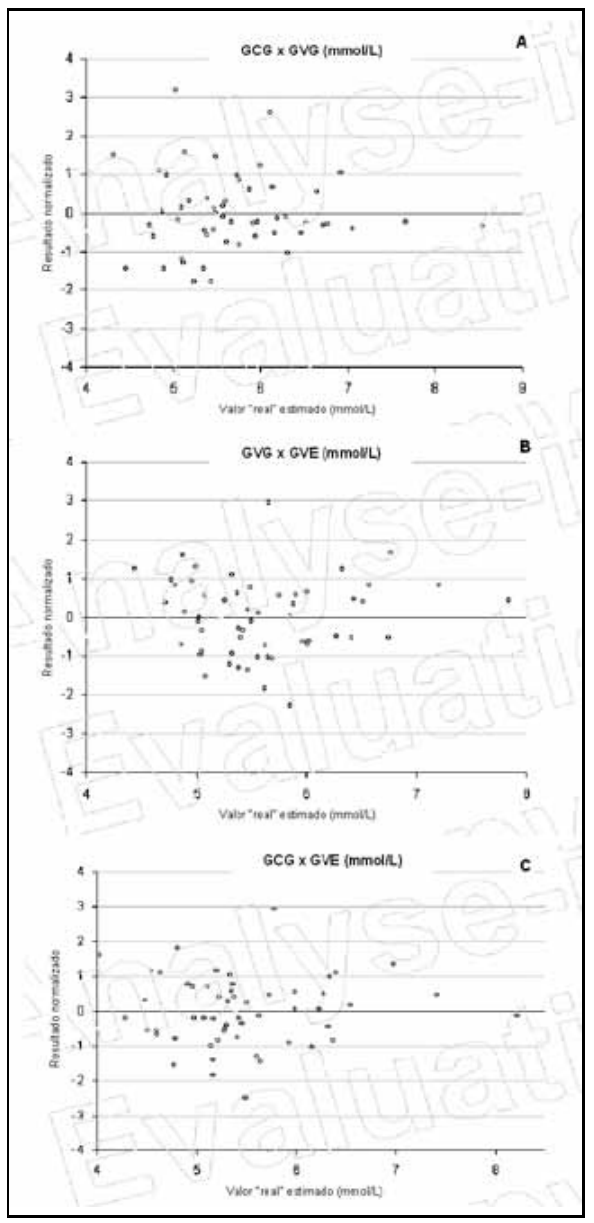
Figura 3 – A: Gráfico dos resultados normalizados derivados da regressão de Deming entre os valores da GCG e da GVG; B: entre a GVG e a GVE; C: entre a GCG e GVE, considerando apenas os pacientes com glicemia alterada GCG: glicemia capilar determinada pelo glicosímetro; GVG: glicemia venosa determinada pelo glicosímetro; GVE: glicemia venosa determinada em plasma pelo método enzimático.